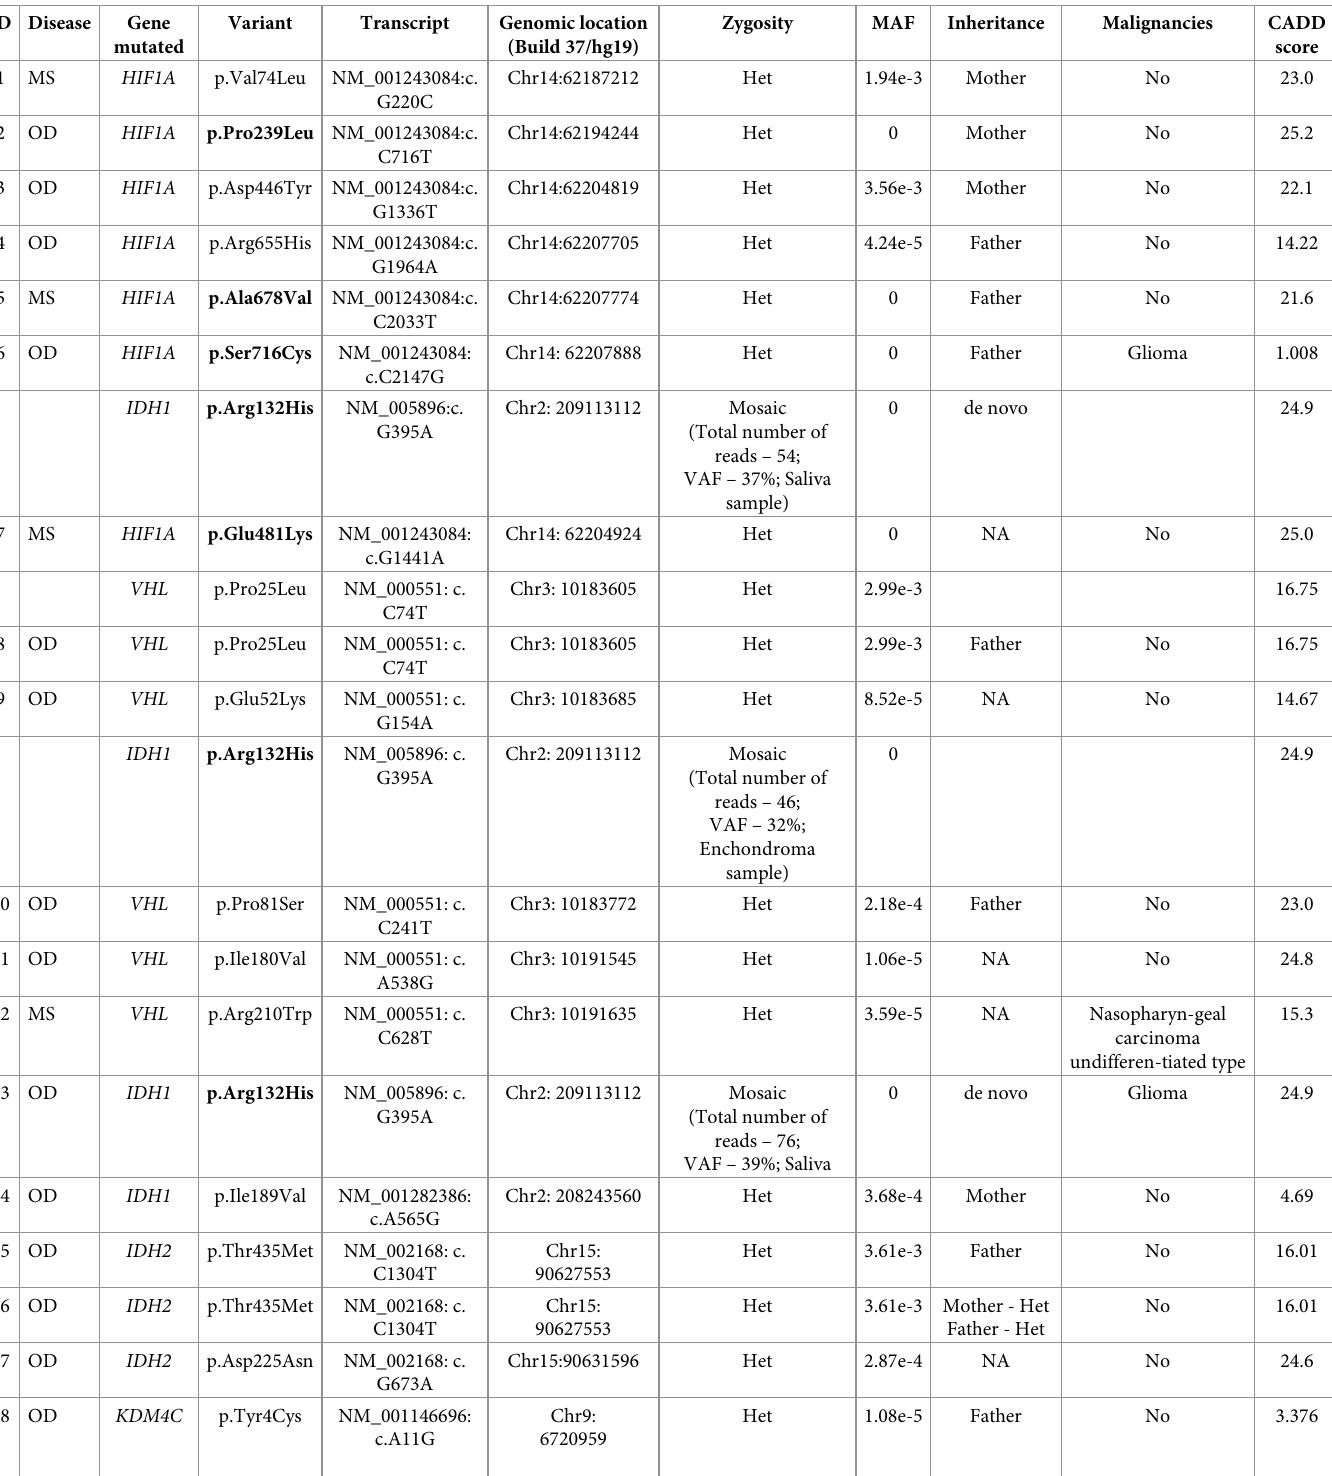
Table 1. Candidate causative variants in genes related to the HIF-1 pathway identified in our cohort of 94 probands with OD or MS. Minor allele frequency (MAF) for each variant was accessed from the gnomAD version v2.1.1 on October 19, 2021. Inheritance was determined by Sanger sequencing from the parents’ germline samples, if available. Father—variant inherited from unaffected father; Mother—variant inherited from unaffected mother. NA–not available. Het–Heterozygous. bold—not present in